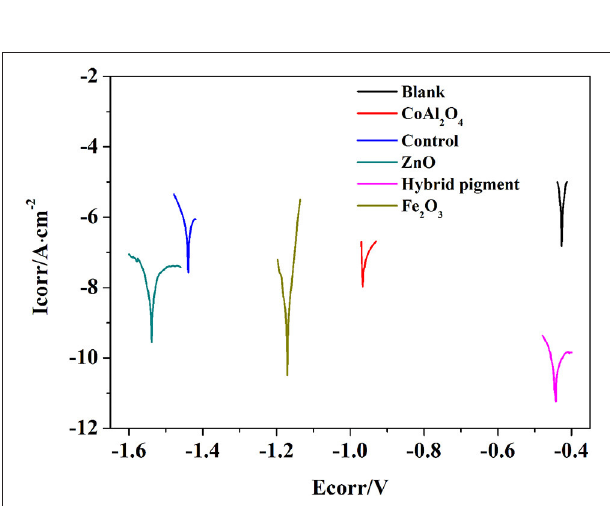
TABLE 4 | Comparison with the anticorrosion performance of the reported additives and hybrid pigment in epoxy anticorrosive coating. Condition